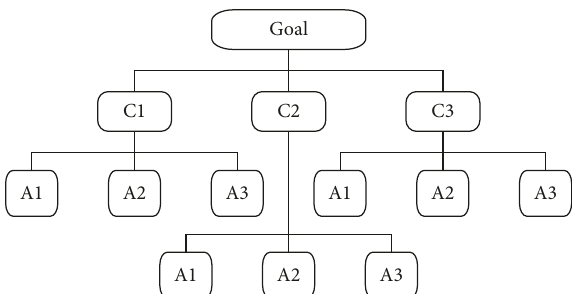
Figure 1: Example of a fundamental three-level hierarchy encompassing three criteria and three alternatives under each